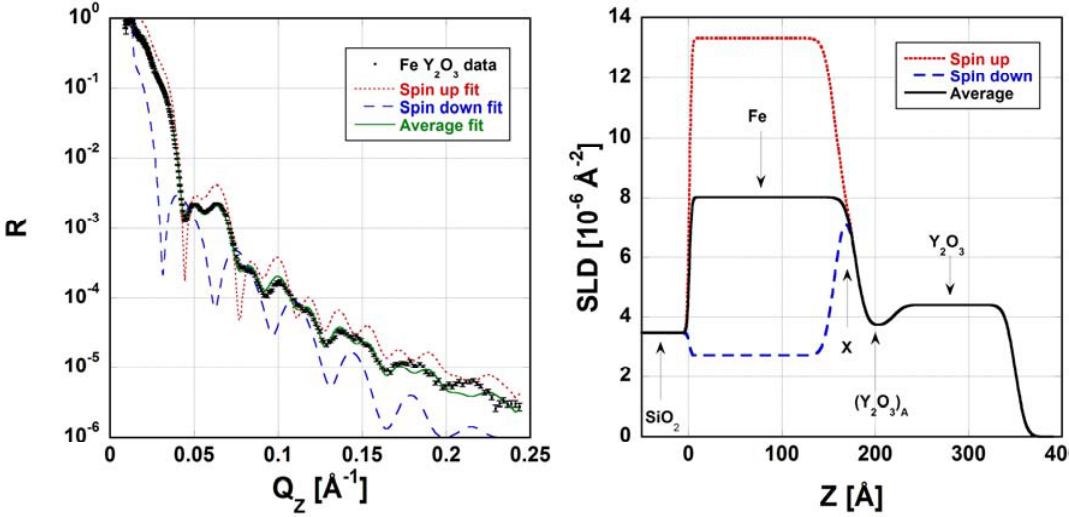
Figure 5. The neutron reflectivity ( left ) of the α‐ Fe and Y 2 O 3 interface investigated by Watkins et al. is the average of SLD contributions from spin-up and spin-down states of the neutron beam ( right ). The depth at which ferromagnetic ordering is lost is marked with an “x” in the right panel. Also in the right panel, (Y 2 O 3 ) A refers to a distinctive Y–O layer forming at this metal/oxide interface. Reprinted with permission from Reference [71]. Copyright (2014), AIP publishing LLC.